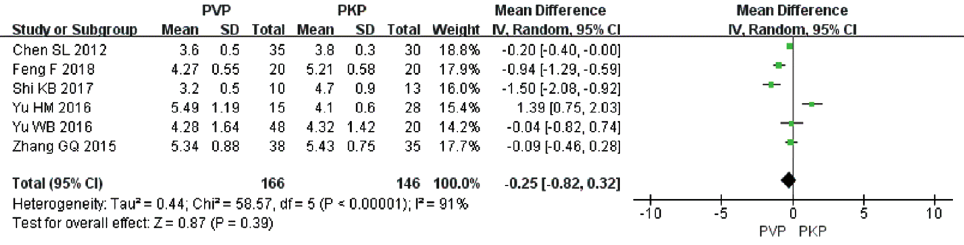
Figure 6. Forest plot to assess cement volume between two procedures.